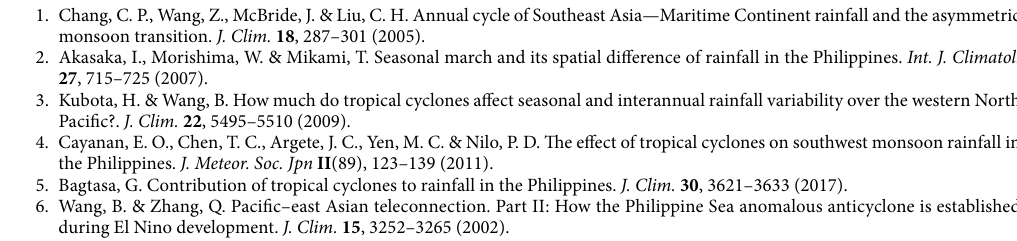
and precipitation mainly over the eastern Luzon and the nearby oceans. At 02 h (Fig. 8c), the circulation was also dominated by large-scale low-level easterly diurnal wind anomalies (blue arrow), island-scale land breeze (yellow arrow), and mountain breeze (red arrow). However, compared to the case at 20 h, the island-scale land breeze and mountain breeze over Luzon were enhanced at 02 h; this could further enhance the low-level wind convergence over the ocean near eastern Luzon, and the related precipitation was also enhanced and pushed eastward. All these features together lead to the eastward propagation of diurnal precipitation features seen over Luzon and the nearby oceans in spring. Notably, this study is the first to demonstrate the role of large-scale LSB-like circulation in modulating diurnal precipitation formation over Luzon. Our findings provide new insights into the modulation of the local weather in Luzon by large-scale circulation changes. However, there might be other possible formation mechanisms (e.g., gravity wave 16,25 , thermal instability, cold pool outflow 11,26 , etc.) contributing to the eastward propagation feature that have not been included in our discussion; this must be investigated further.